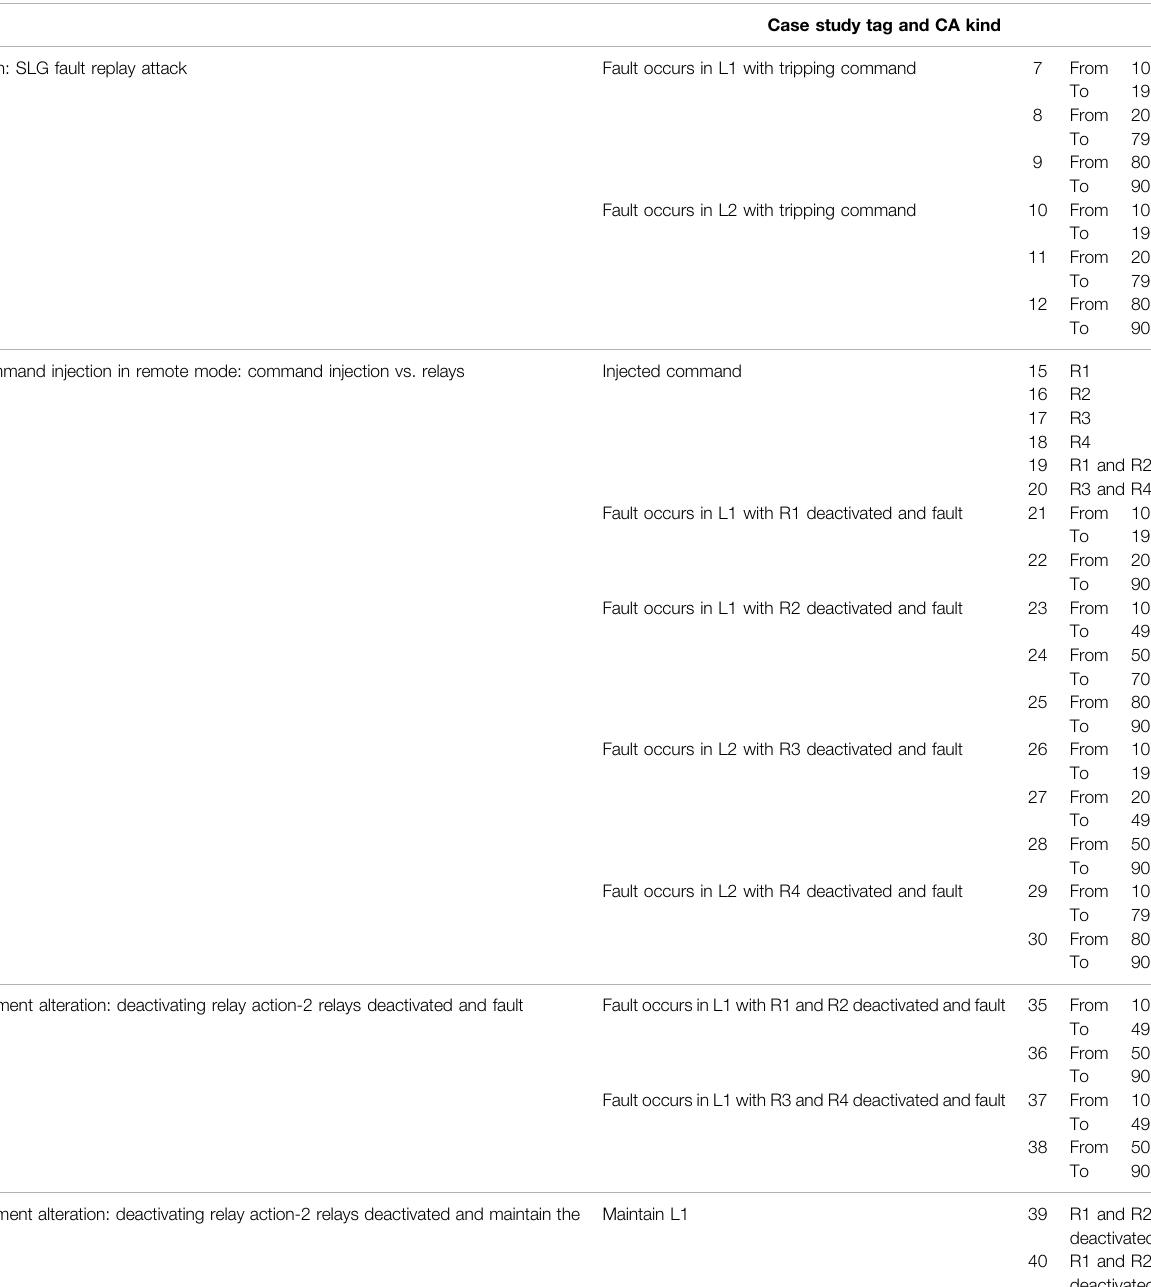
TABLE 3 | CA occurrence case studies for MSU/ORNL information.